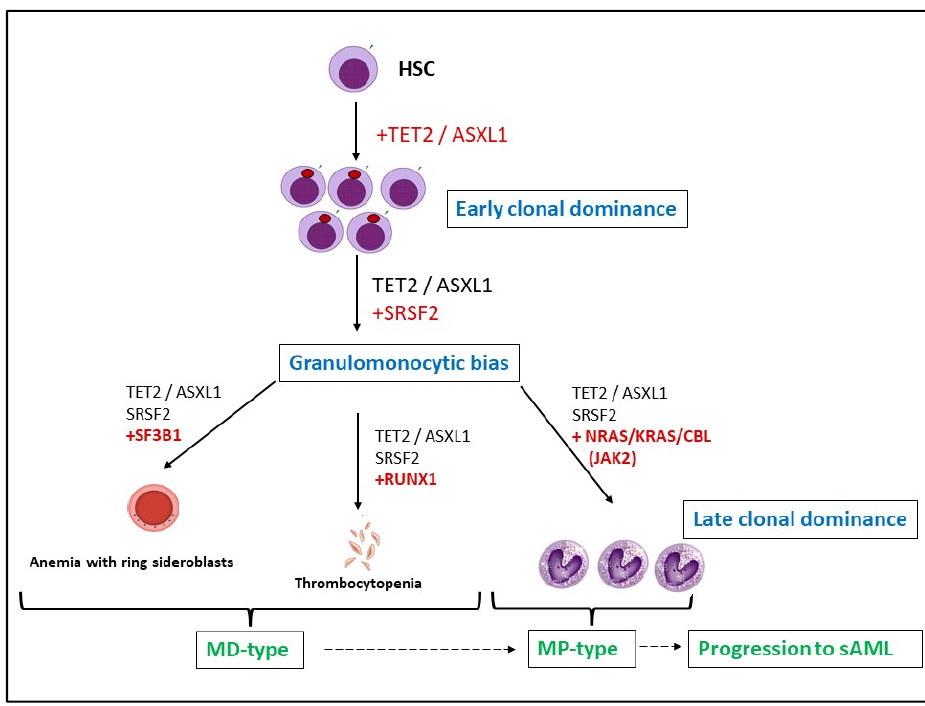
Figure 2. Pathogenesis of CMML. The primary mutations in HSC are TET2 or ASXL1 , which promote early clonal dominance. The secondary molecular abnormalities are likely to be associated with spliceosome components, commonly SRSF2 , resulting in granulomonocytic lineage bias. The third event, which is responsible for late clonal dominance, may involve: (1) SF3B1 mutations resulting in anemia; (2) RUNX1 —thrombocytopenia; (3) mutations in NRAS , KRAS , CBL , and JAK2 —progression of clone. HSC—Hematopoietic Stem Cell; MD-type—myelodysplastic type of CMML; MP-type—myeloproliferative type of CMML.